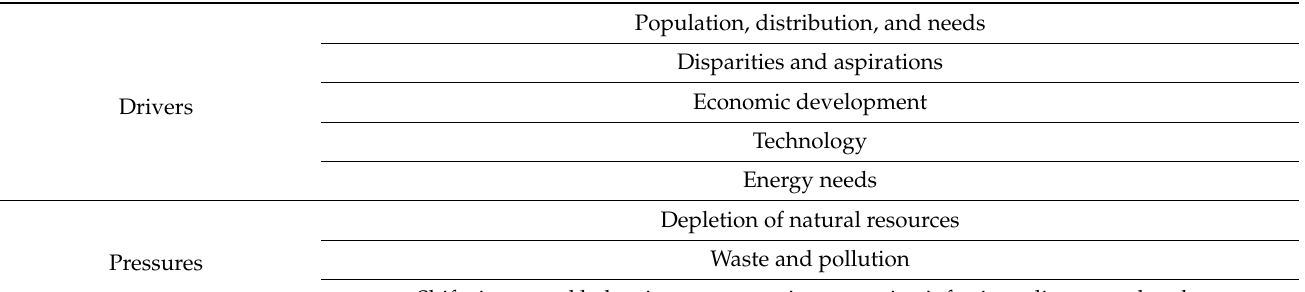
Table 3. Sub-competencies for Domain 2: Upstream Drivers of Climate and other Environmental changes.